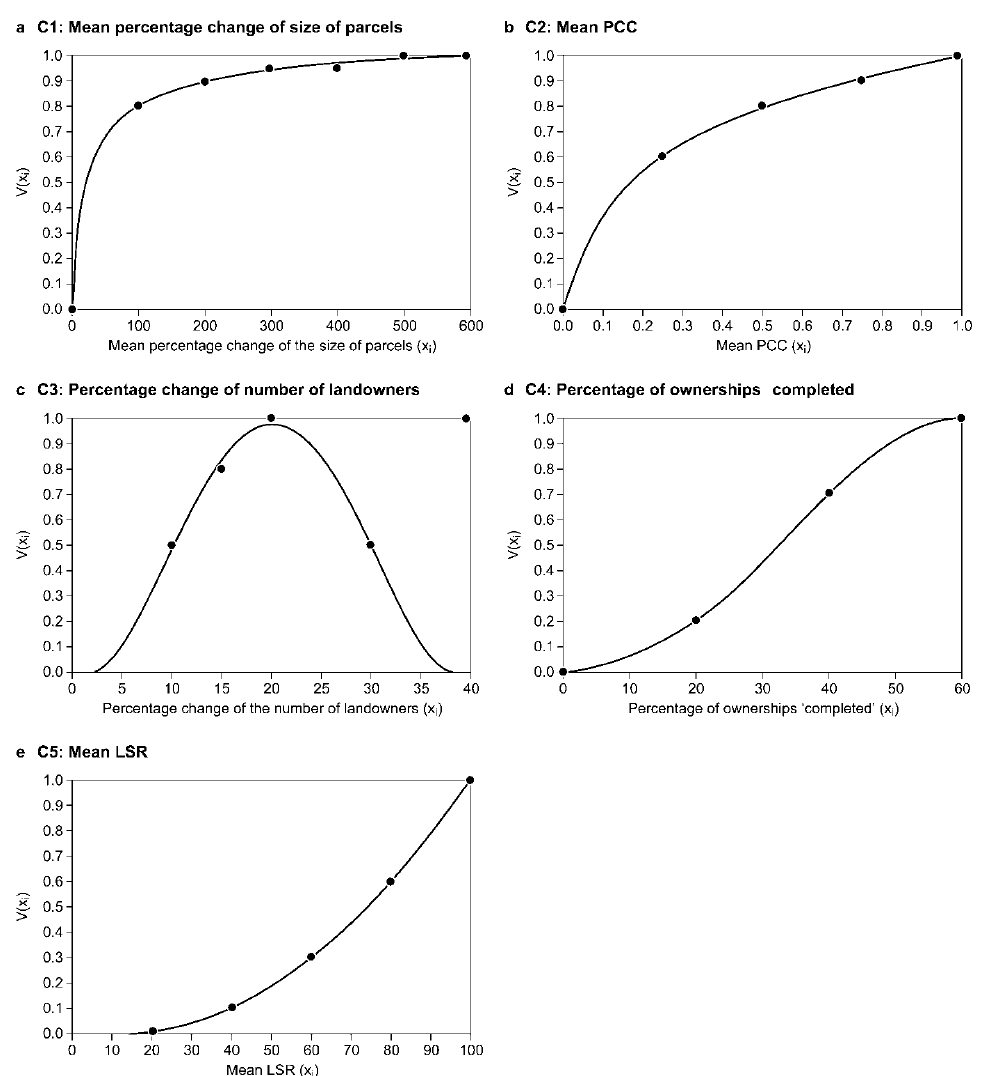
Figure 3. The value functions for the evaluation